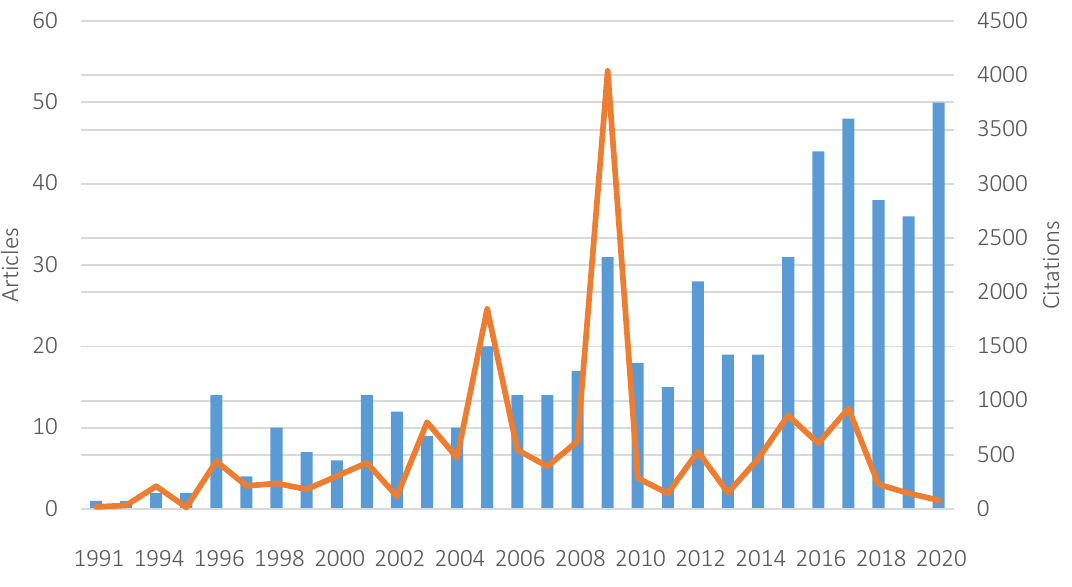
Figure 1. Annual distribution of IMC literature (WoS and